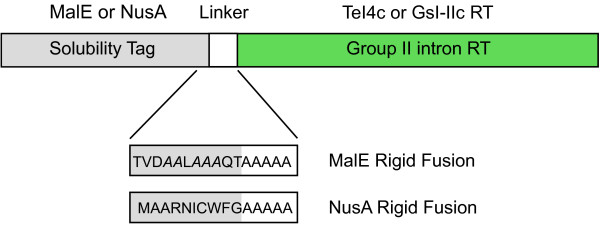
Thermostable group II intron reverse transcriptase (RT) fusion proteins. High-level expression of thermostable group II intron RTs that remain soluble when purified free of bound RNAs is achieved by expressing the RT as a fusion protein with a solubility tag, such as MalE or NusA, linked to the N-terminus of the RT via a non-cleavable rigid linker [10]. In these examples, the rigid linker consists of five alanine residues and the MalE and NusA tags are modified (MalE, charged amino acids changed to alanines (italics); NusA, two C-terminal amino acids deleted) to reduce conformational flexibility at the fusion junction and achieve an optimal spacing between the solubility tag and the group II intron RT [10].